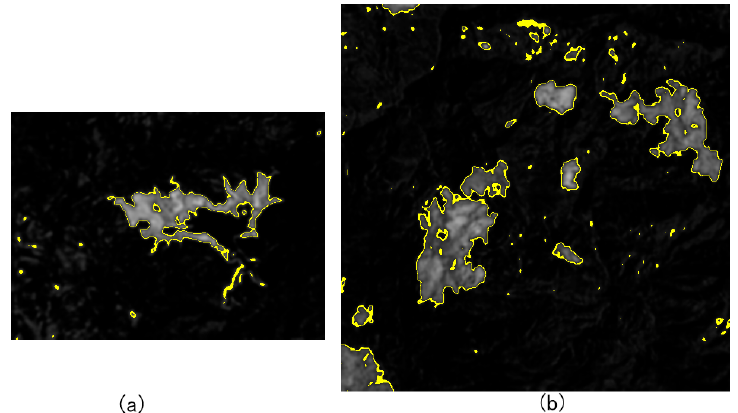
Figure 5. Distribution of pixels that are within the threshold range obtained by the TRP (the yellow pixels are the uncertain pixels; the value of these uncertain pixels are within the proposed TRP; the bright pixels are the pixels with high change probability, and the black pixels are the unchanged pixels): ( a ) FCMI of Sardinia Island datasets; and ( b ) FCMI of Mexico datasets.